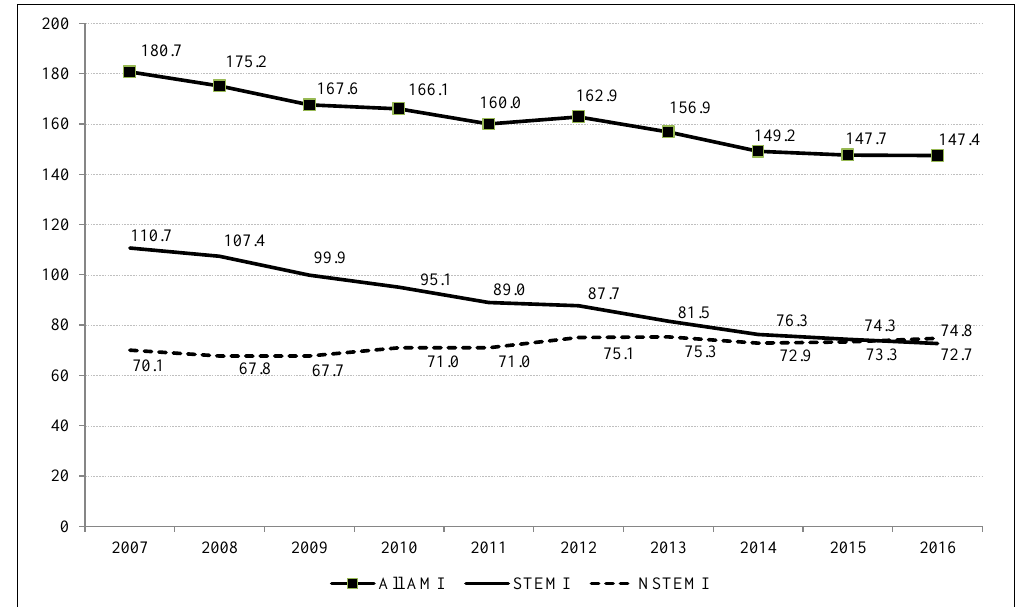
Figure 1. Veneto Region 2007–2016. Temporal trends in hospital admissions for AMI * (per 100,000 population), initial episode of care, by type of AMI, after direct standardization (reference population: 2012). AMI: acute myocardial infarction. * APC (CI 95%), p -value → All STEMI = − 2.3 ( − 2.6; − 1.9), p < 0.001; STEMI = − 4.8 ( − 5.3; − 4.4), p < 0.001; NSTEMI = 1.1 (0.4;1.7), p < 0.001. The mean age of the STEMI population was 70.1 ± 14.3 years, and males accounted for nearly two thirds of the patients hospitalized with STEMI (men: 66.2%; women: 33.8%). The majority of